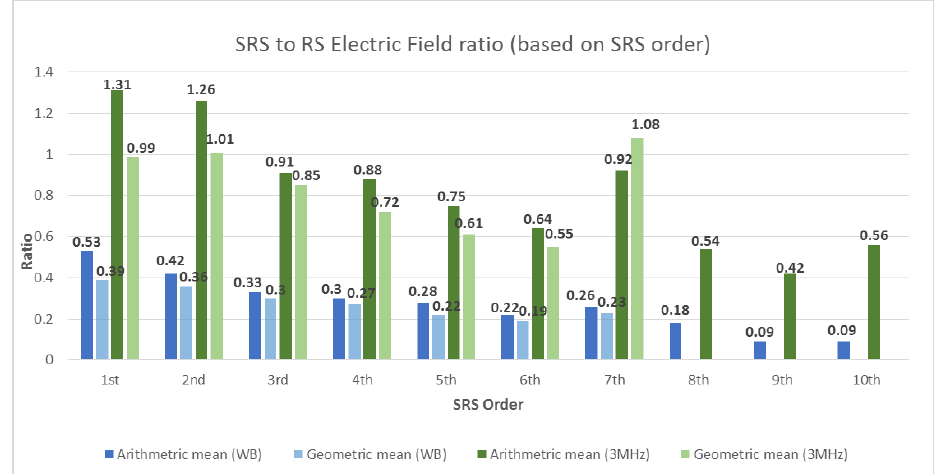
Figure 6. The SRS to RS electric field amplitude ratio based on SRS order with 3 MHz. WB = wideband.